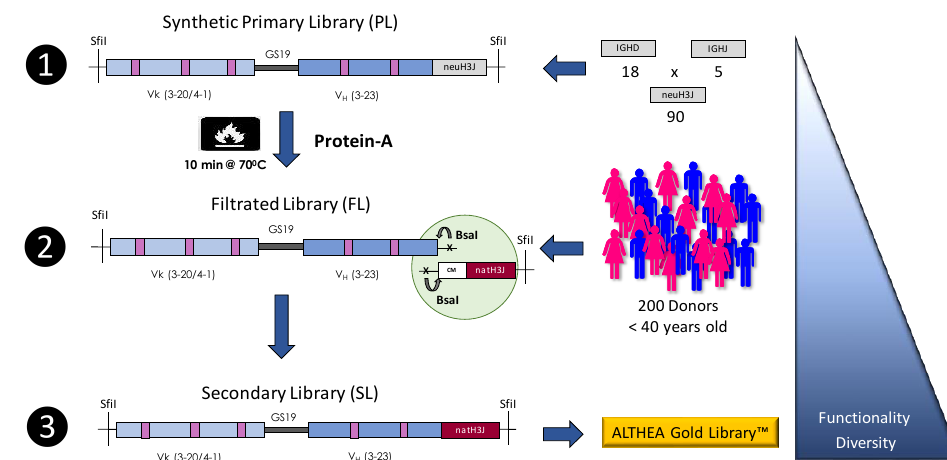
Figure 4. Taken from Valadon et al. [33] with permission. The figure describes the three- Figure4. TakenfromValadonetal.[33]withpermission. Thefiguredescribesthethree-stepconstruction process of ALTHEA Gold libraries ™ . Step 1: Primary synthetic scFv libraries (PLs) based on the two sca ff olds 3-20 / 3-23 and 4-01 / 3-23, combined with a set of 90 neutral H3J fragments, were